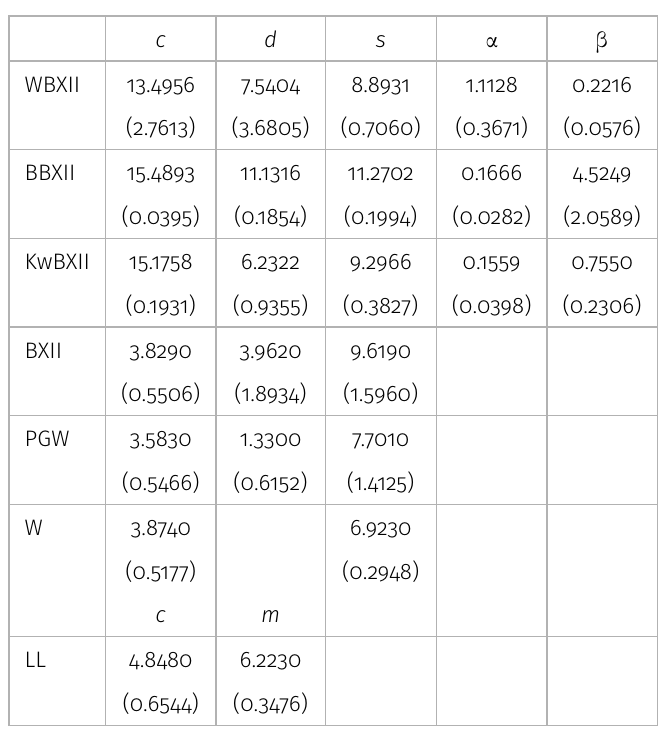
Table V. MLEs of the model parameters and their standard errors in